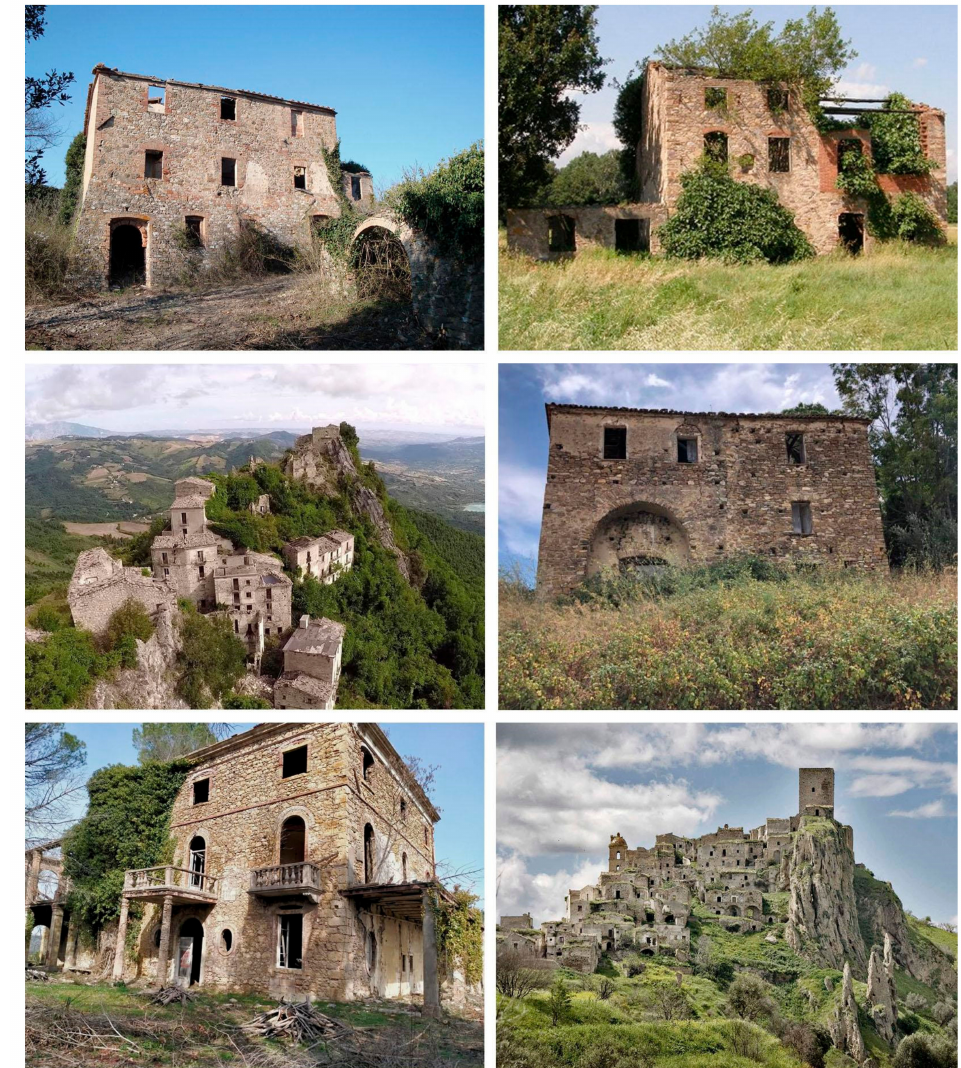
Figure 1. Some examples of isolated and aggregated buildings in a state of